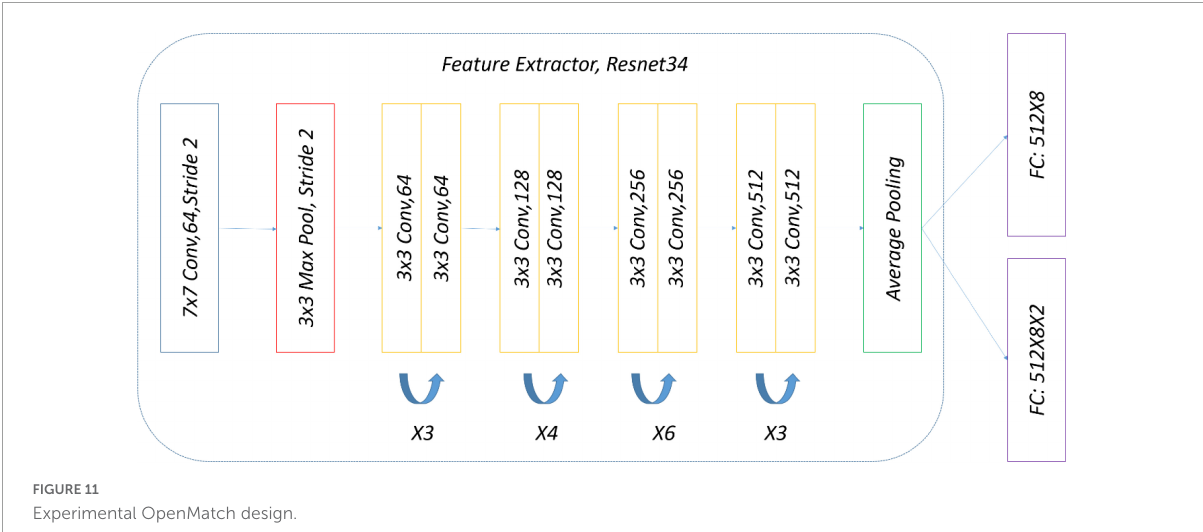
FIGURE11 Experimental OpenMatch design.